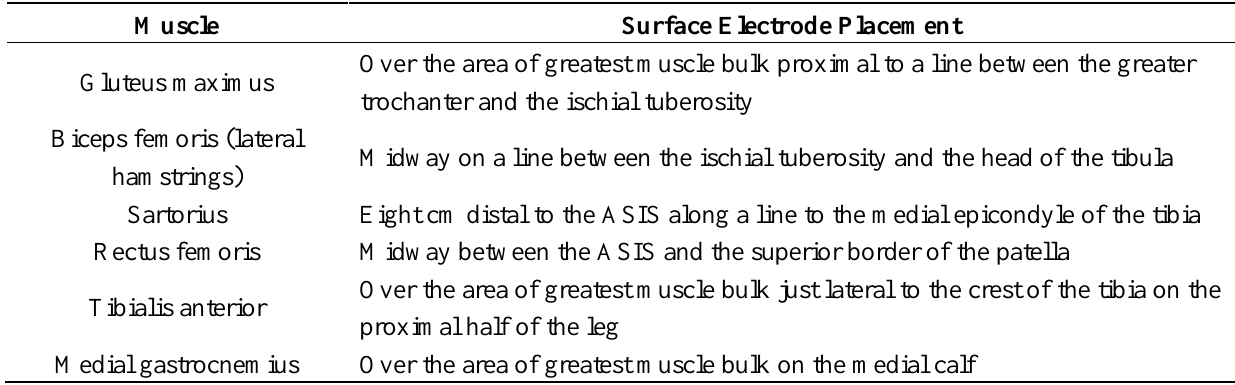
Table 1. Surface electrode placement according to the Winter guidelines [29].